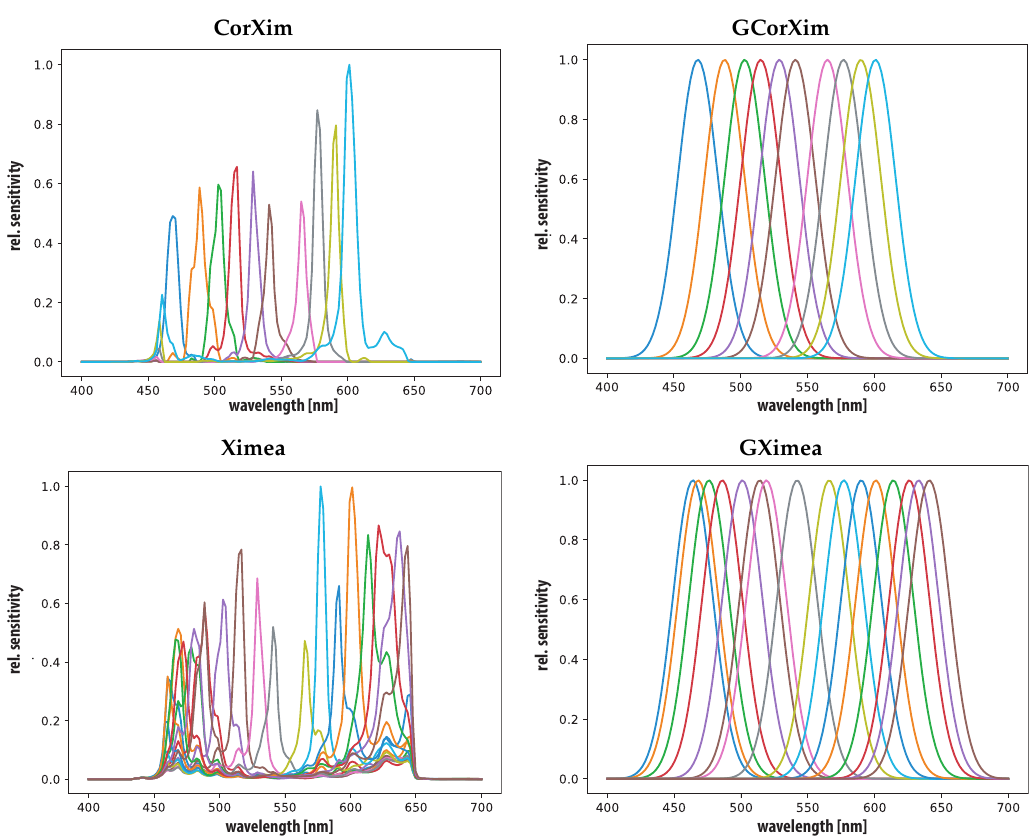
Figure 4. Sensor sensitivities, Ximea xispec [4] (Ximea and CorXim) (all left ) and simulated GSB (GCorXim and GXimea) versions (all right